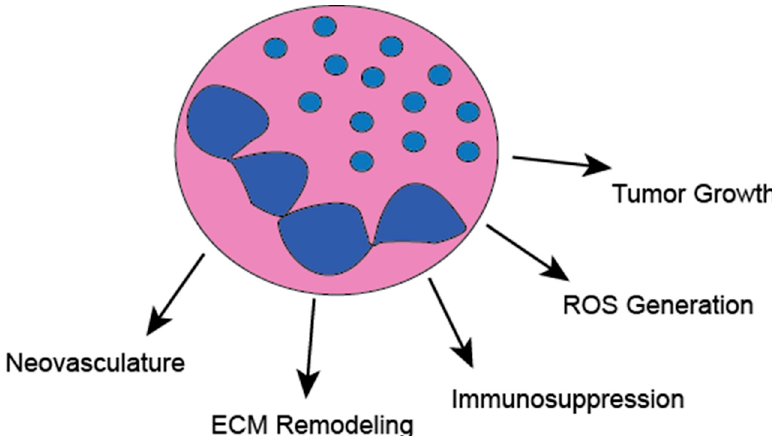
Figure 2. Neutrophils have diverse function in the progression of tumors. Neutrophils directly stimulate tumor angiogenesis. Neutrophils can directly inhibit anti-tumor immunity through the expression of checkpoint molecule PD-L1, stimulate tumor growth through the secretion of neutrophil elastase, facilitate tumor invasion and metastasis through ECM remodeling and generation of neutrophil extracellular traps, and directly contribute to tumorigenesis through the generation of genotoxic reactive oxygen species.